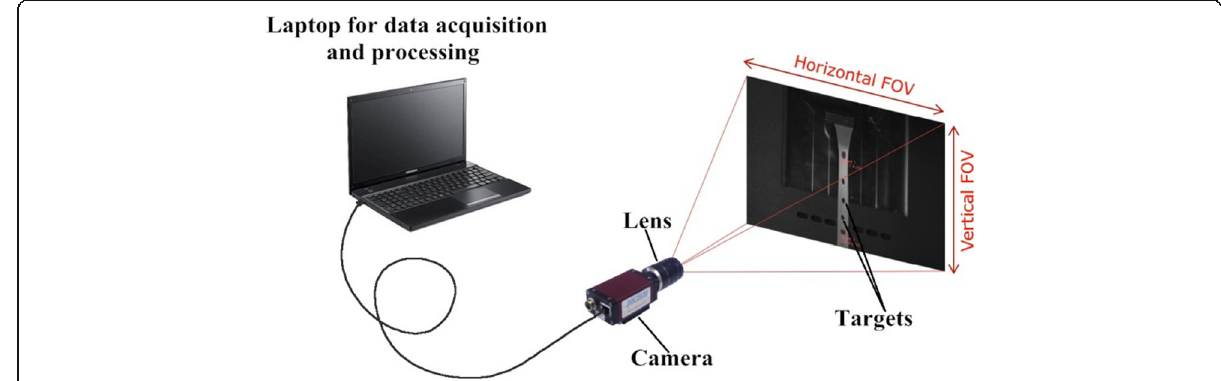
Fig. 4 Components of the non-contact video-based measurement system